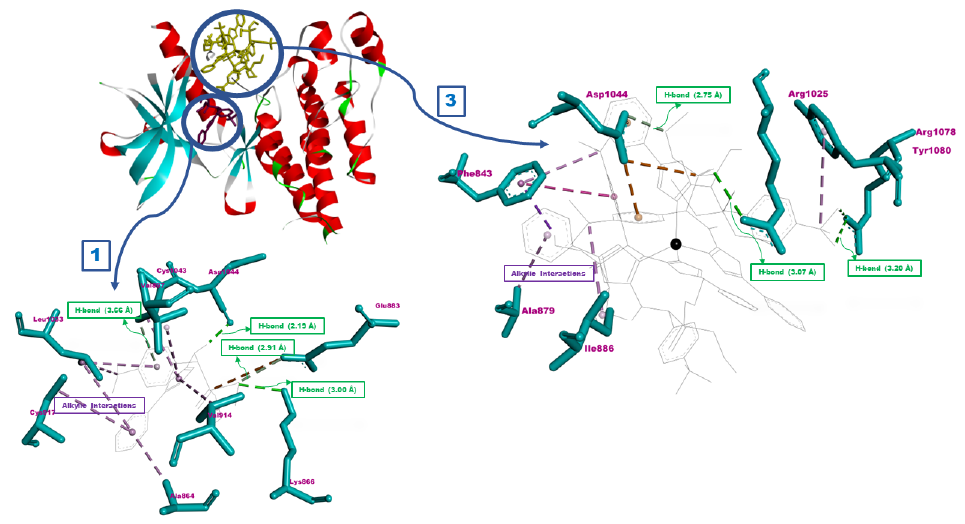
Figure 8. Interaction residue and interaction type of the molecules ( 1 and 3 ) with VGEFR ‐ 2 crystal structure.